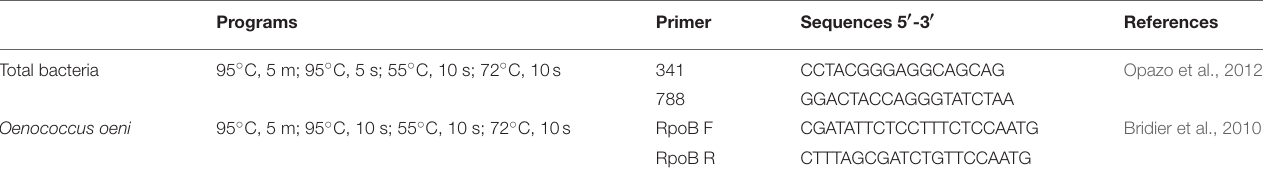
TABLE 1 | Primers and programs for quantitative